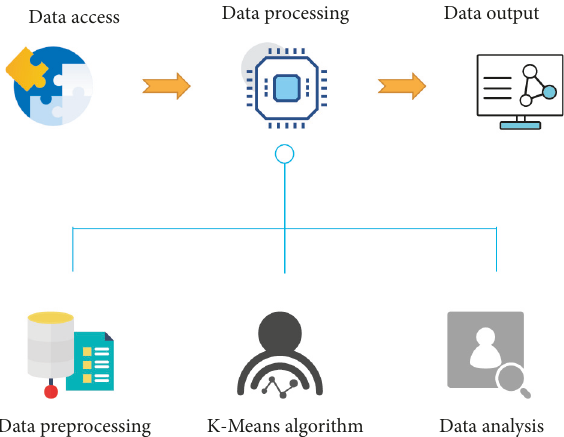
Figure 2: Construction of system